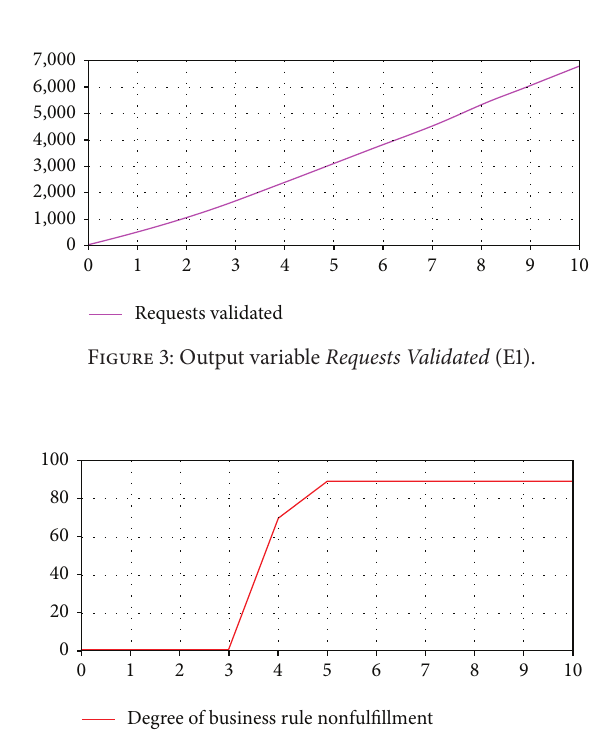
Figure 4: Output variable Business Rule Fulfillment (E3).